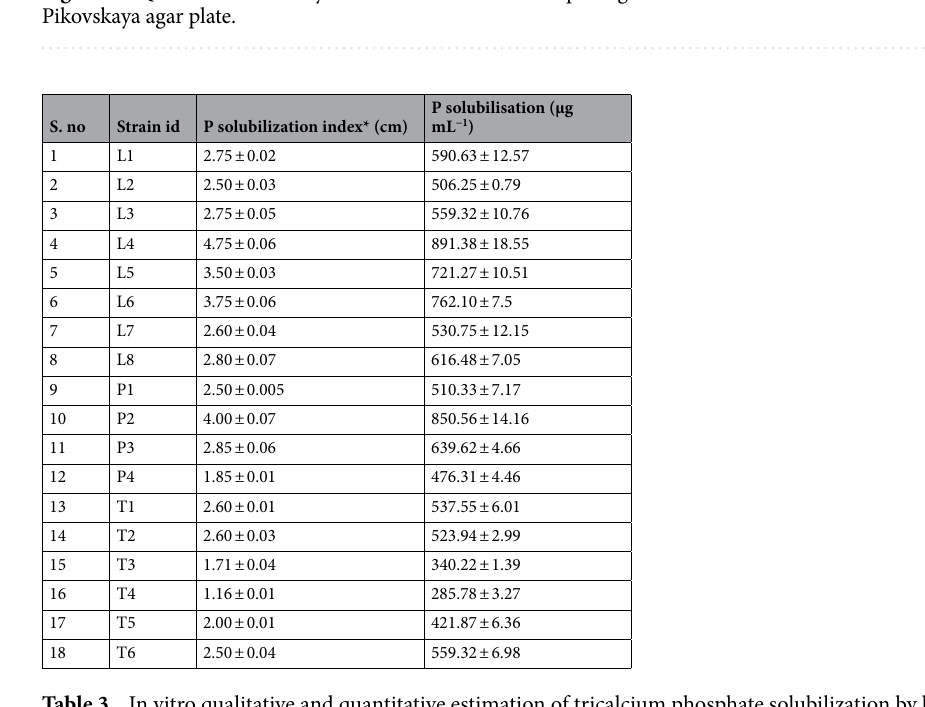
Table 3. In vitro qualitative and quantitative estimation of tricalcium phosphate solubilization by bacterial isolates. *Values are the mean of triplicates with standard error of mean.